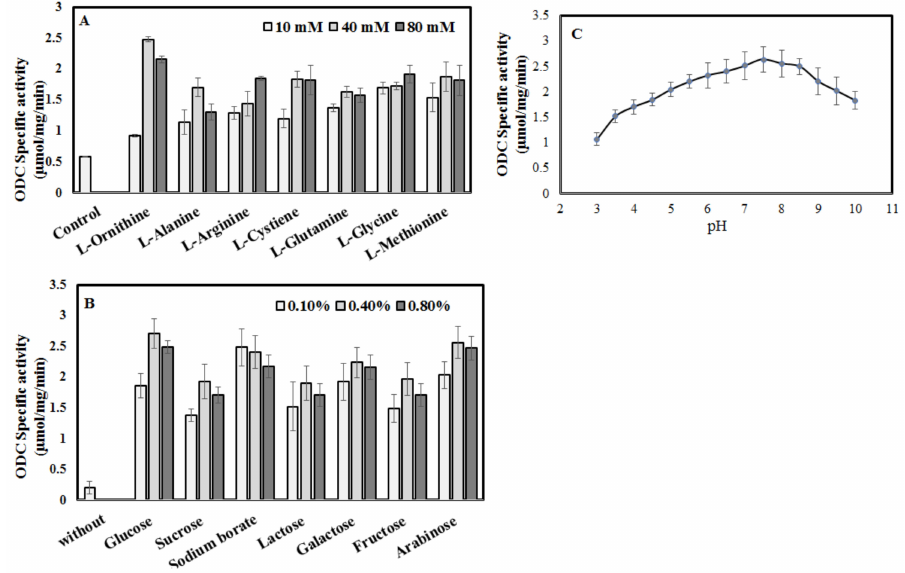
Figure 2. Cultural optimization of Aspergillus terreus to maximize its productivity for ODC. Di ff erent nitrogen sources ( A ), carbon sources ( B ) and initial pH values of the medium ( C ) were evaluated based on the ODC productivity by A. terreus